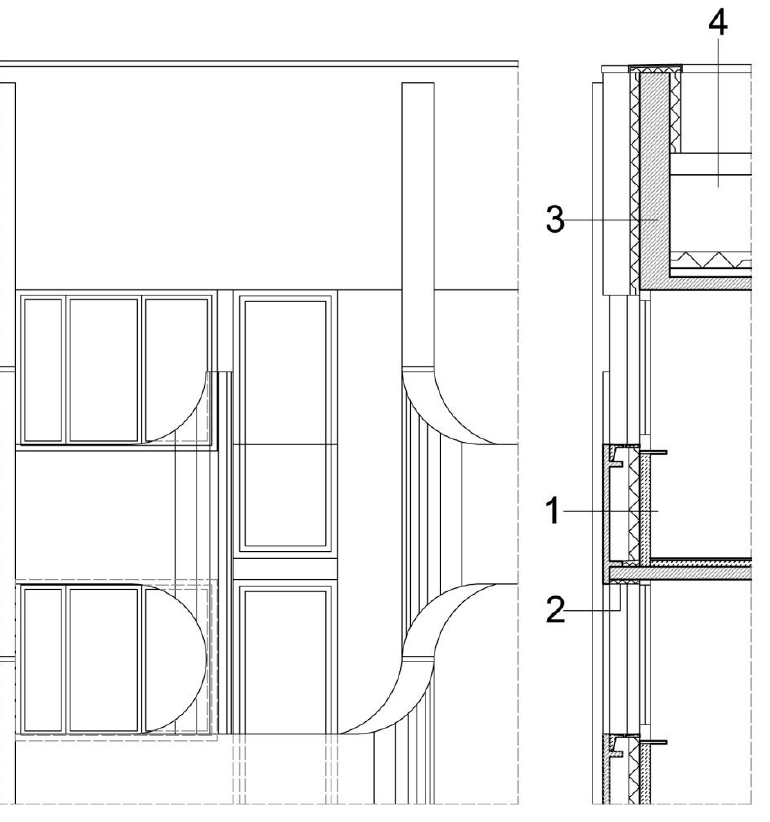
Figure 4. The façades of residential buildings at Grunwaldzki square–elevation and section. 1. The designed external wall (prefabricated): repaired and painted white prefabricates 6.0 cm, external void, mineral wool 8.0 cm, internal walls made of asbestos removed and replaced with light concrete blocks 12.0 cm, internal plaster 1.5 cm. 2. Insulation of loggias–mineral wool. 3. The designed external wall: silicone plaster 1.5 cm, mineral wool 8.0 cm, aerated concrete blocks or reinforced concrete wall 24.0 cm, internal plaster 1.5 cm (between windows). 4. The designed roof slab: 2x roofing felt, levelling layer 2.0 cm, slag concrete slabs in decline 8.0 cm, ventilation gap 5.0–30.0 cm, blown-in mineral wool granules in the air cavity 20.0 cm, prefabricated channel slabs 24.0 cm, internal plaster 1.5 cm (drawn by the Authors).